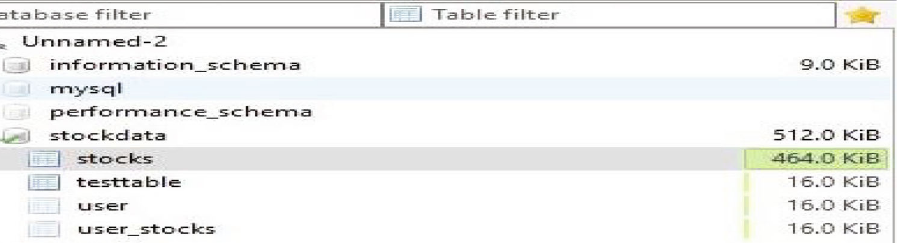
Figure 5: Snapshot of stock and user data tables.